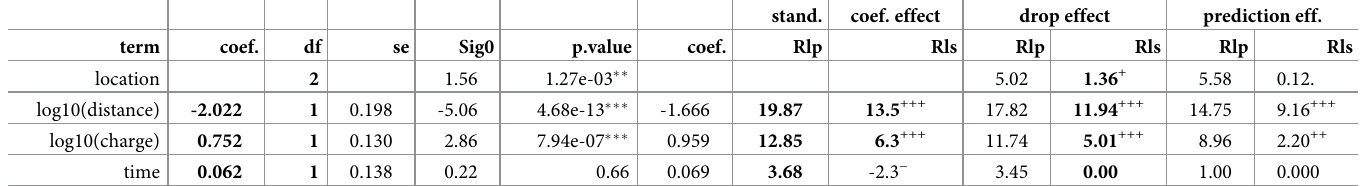
Table 7. Extensive results for the blasting expample location is a factor with 3 levels. Relevance thresholds are 10% for standardized coefficients and 5% ℓ for the pre- diction effect. The columns shown in bold face should be routinely shown.